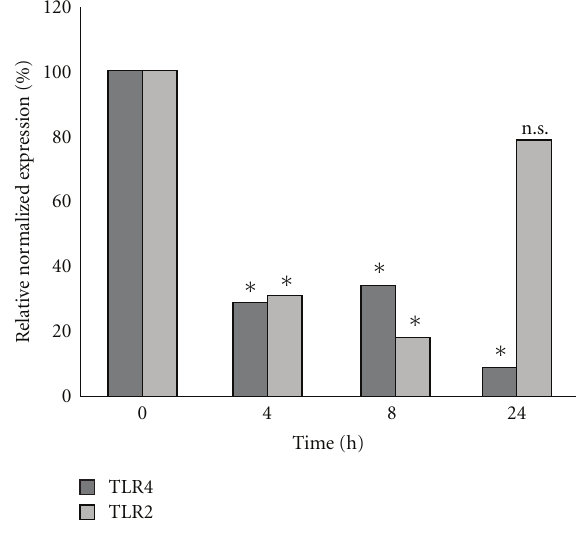
Figure 4: Gene expression of TLR2 and TLR4 was analyzed by quantitative Real-time RT-PCR. Data shown represent mean expression of TLR2 and TLR4 in percent. TLR expression was nor- malized against h-ALAS housekeeping-gene. ∗ Indicates statistical significant di ff erence ( P ≤ . 05).